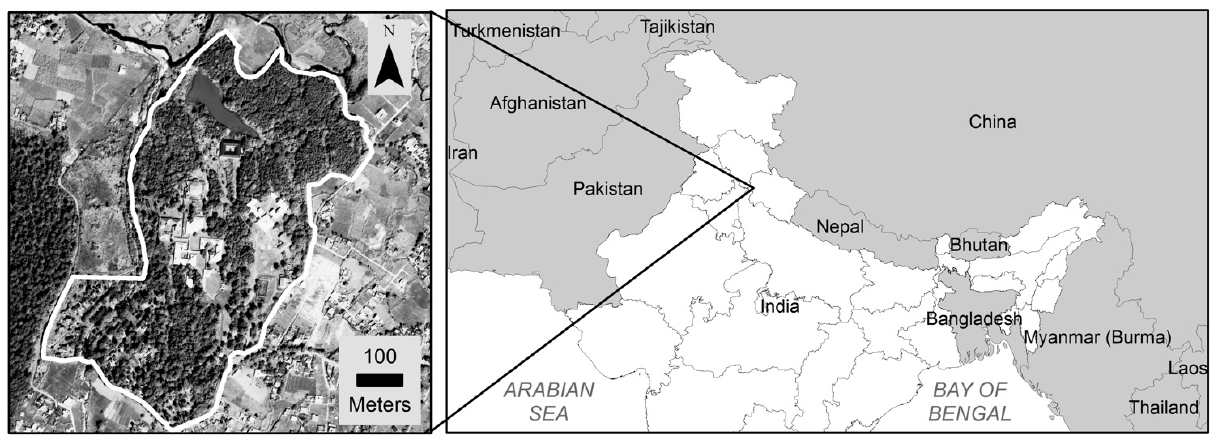
Figure 2. Study Area, Wildlife Institute of India